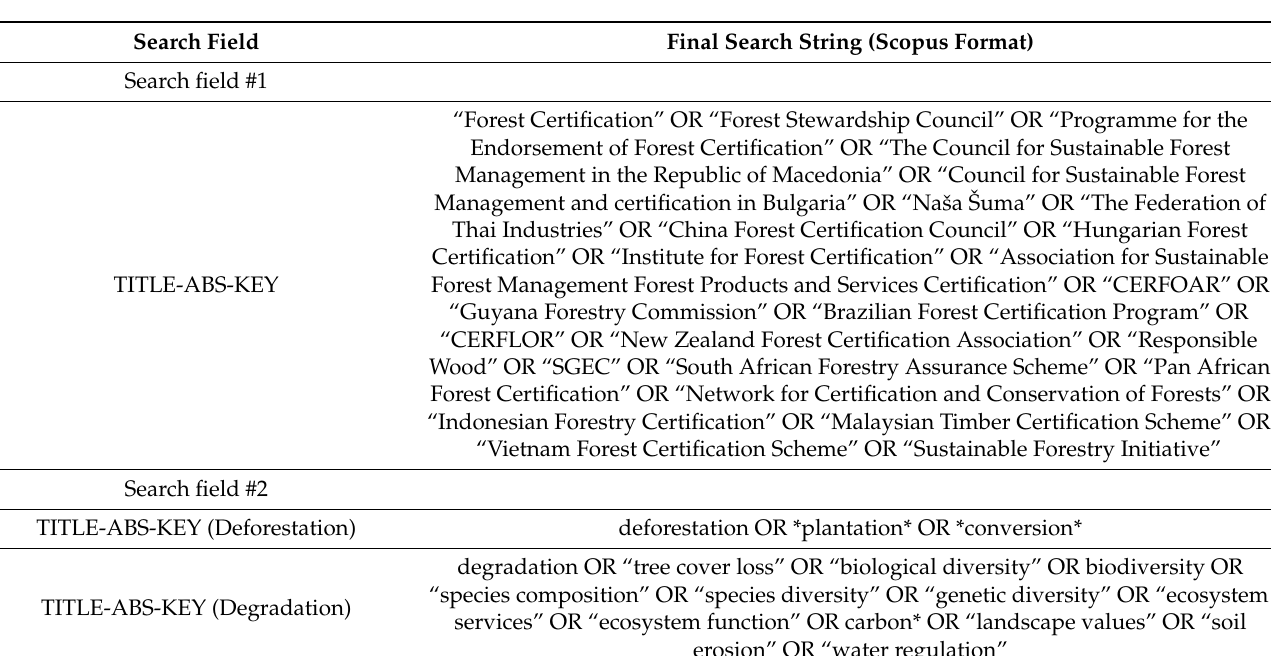
Table 1. Final search strings. The truncation symbol (*) behind/before a word stem ensures that other word forms can be retrieved, e.g., carbon* = carbon sequestration, carbon emissions, or *plantations = forest plantations,